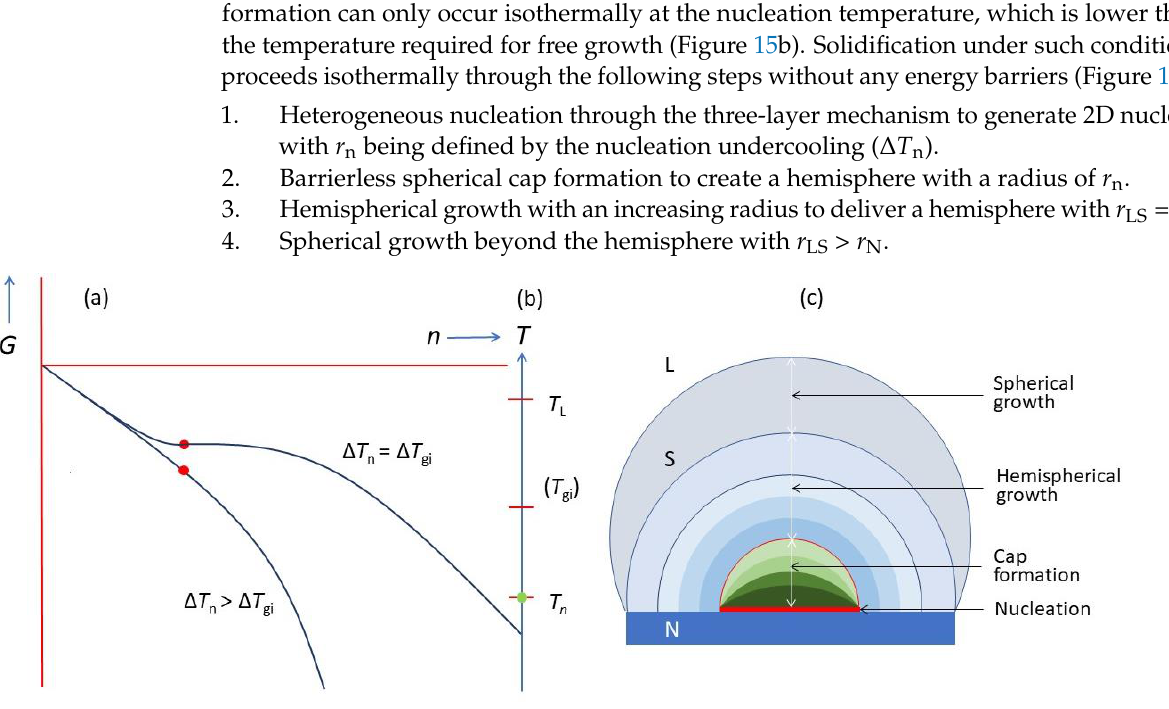
Figure 14. Time-averaged atomic positions of a simulation system with −8 % lattice misfit demon- strating the unconstrained cap formation process at a constant temperature. Nucleation occurred at Δ T n = 136 K on a substrate of 2r N = 15.7 nm ( Δ T gi = 36.2 K) to provide the 2D nucleus of 2 r n = 4.2 nm (the purple dashed circle at t = 40 ps; see Figure 6). With increasing time, the 2D nucleus grows isothermally initially into a spherical cap (40 ps < t < 50 ps) and then hemispheres with increasing radius ( t > 50 ps). ( a ) Cap formation L3 (top view); ( b ) Cap formation (front view).